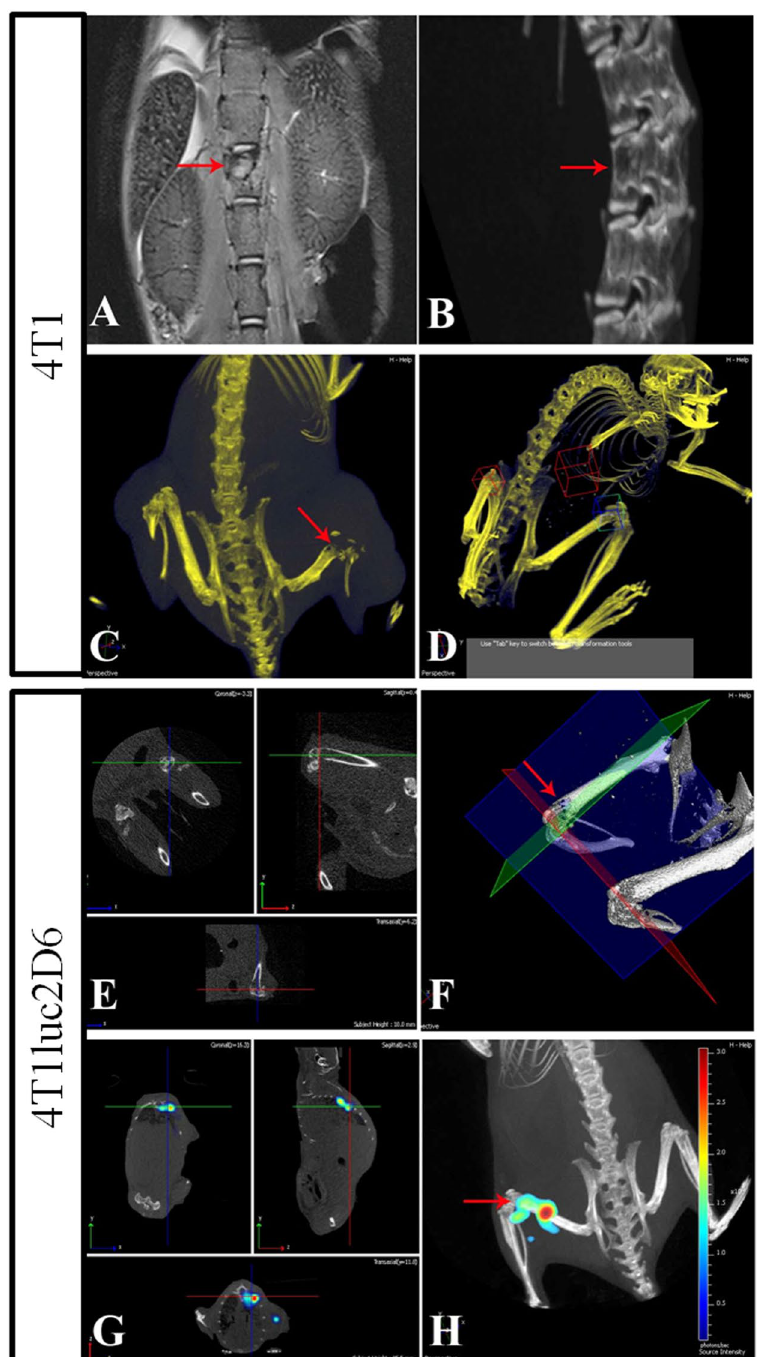
Figure 6. Bone metastases formed by 4T1 ( A – D ) and 4T1luc2D6 ( E – H ) tumors at week 4 after implantation visualized by the combination of MRI, micro-CT and optical imaging. The T2-weighted MRI of a mouse with a 4T1 carcinoma, coronary section, the arrow indicates a metastasis in the vertebral body ( A ); Targeted high- resolution micro-CT of the same mouse with a fragment of 3D reconstruction, the arrow indicates the focus of osteolysis of the vertebral body ( B ); Micro-CT of a mouse with a 4T1 carcinoma on day 28 after implantation, the arrow indicates a osteolytic lesion by metastasis of the distal epiphysis of the right femur ( C ); Micro-CT of a 4T1 mouse with a metastasis in the region of the right knee-joint, the areas subjected to densitometry are highlighted ( D ); Targeted micro-CT of a 4T1luc2D6 mouse, the arrow indicates the metastasis in the distal epiphysis of the right femur ( E , F ); 4T1luc2D6 metastasis in the vertebral body ( G ) and the lower third of the left femur ( H ) visualized by bioluminescent